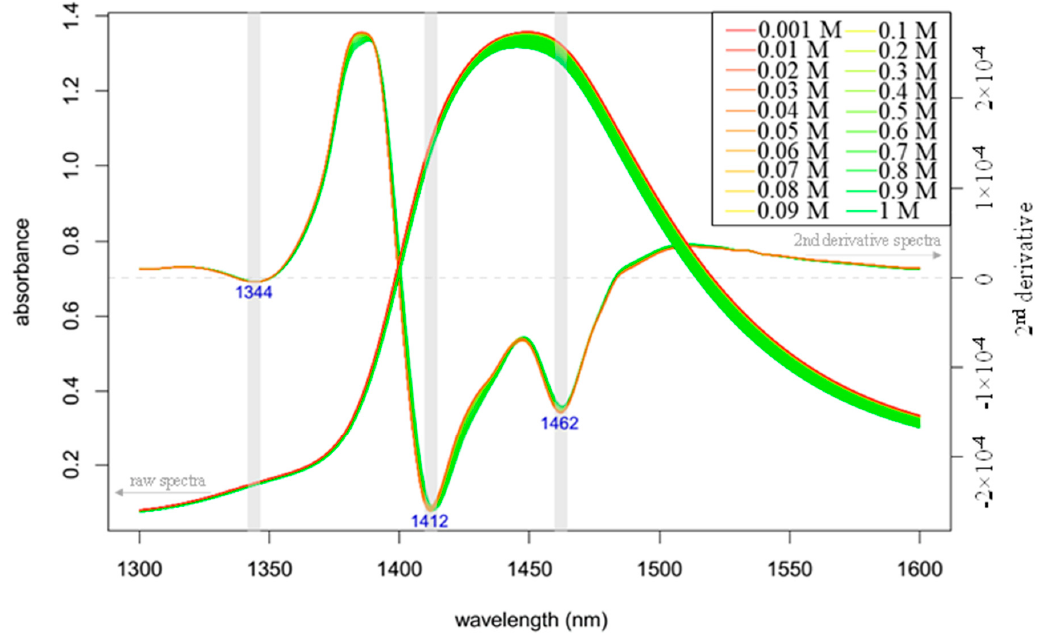
Figure 4. Raw and 2nd derivative (calculated with Savitzky–Golay filter using 2nd order polynomial and 21 points) absorbance (logT − 1 ) spectra in the range of 1300–1600 nm (OH first overtone) of 0.001–1 M KCl solutions ( n = 180).